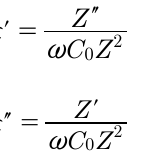
The real ( ε’ ) and imaginary ( ε” ) components of the complex permittivity ( ε* ) are related with the imaginary and real components of the impedance as follows, where, C is the capacitance of the sensor on air. The real part of the 0 permittivity is also named as the dielectric constant of the material, while the imaginary part represents its loss